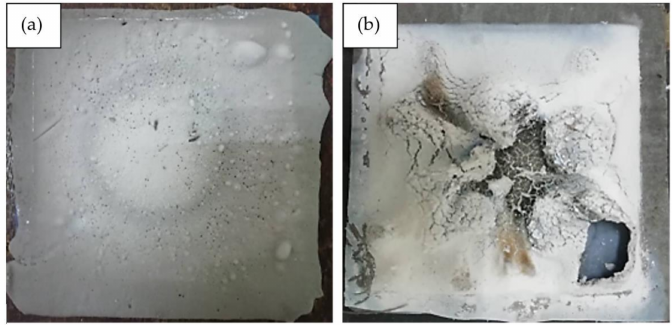
Figure 10. ( a ) Control sample and ( b ) optimized sample after the fire retardant test. 3.5. Microstructure Analysis of RHA/SiR-Based Binary Blended Geopolymer Coating Composite